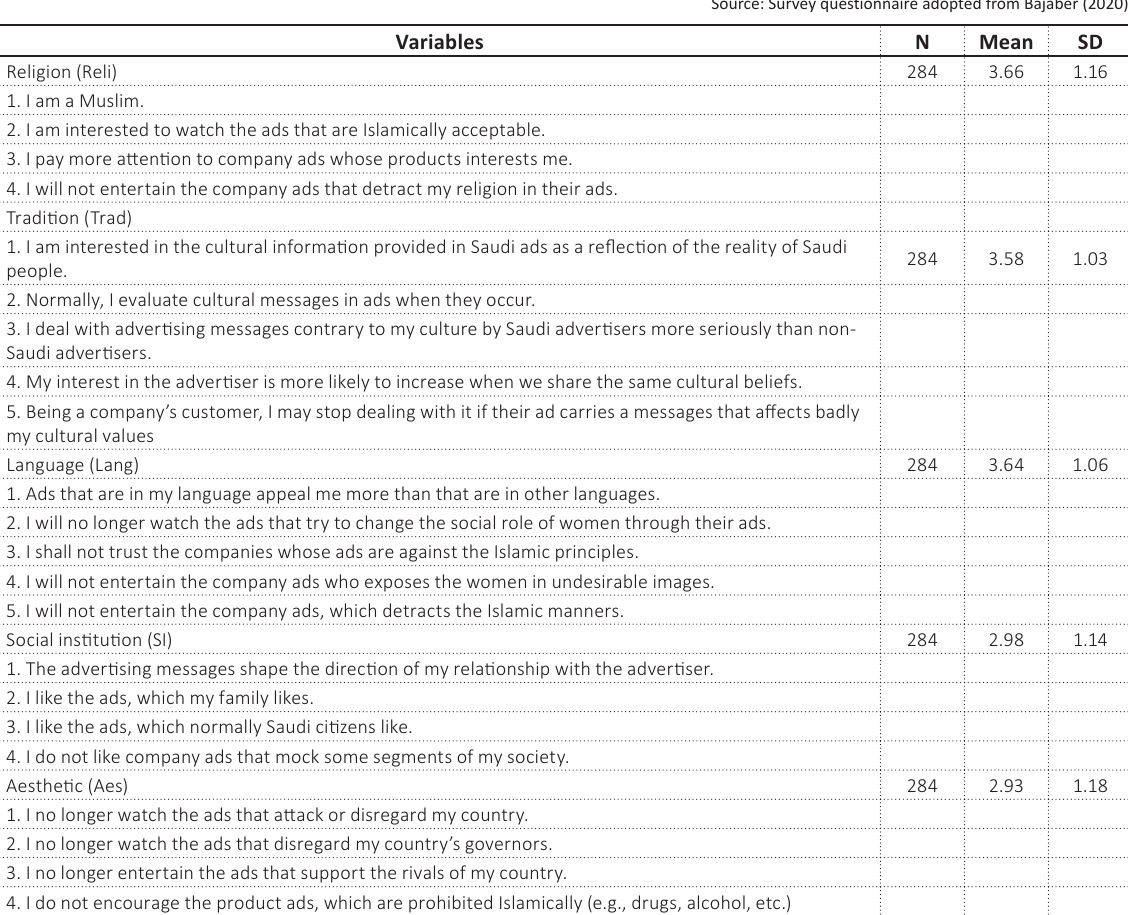
Table 2. Cultural values of customers towards ads